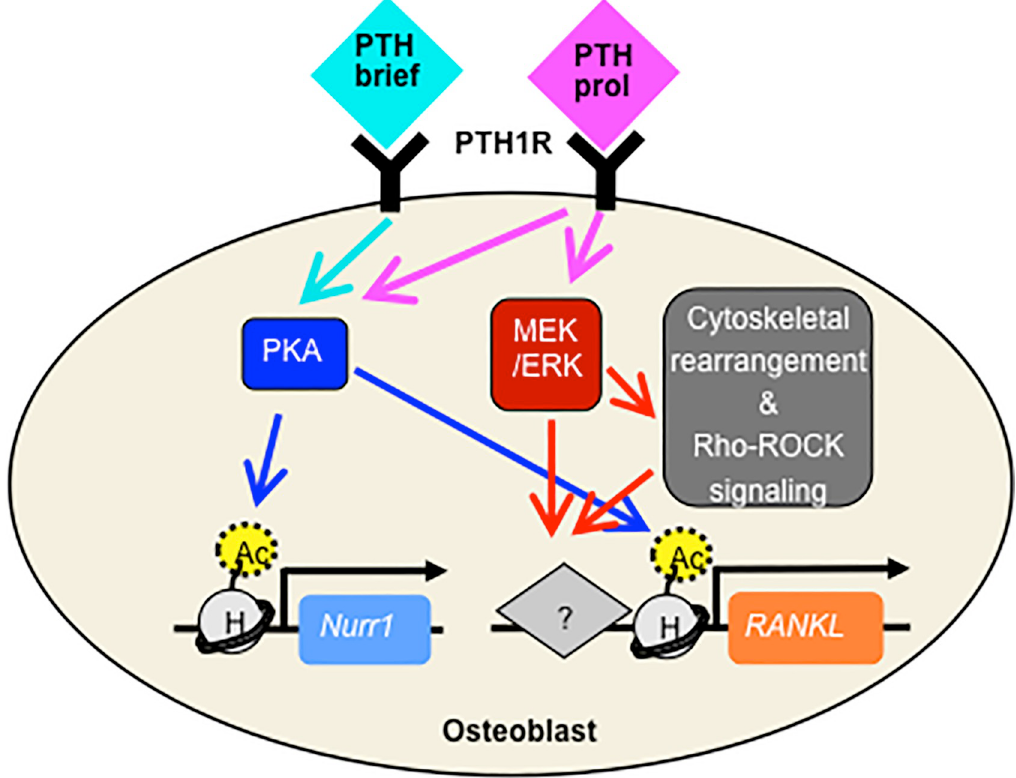
Fig 7. A schematic figure illustrating differential regulatory mechanisms of brief vs. prolonged PTH for Nurr1 and RANKL induction in osteoblasts.